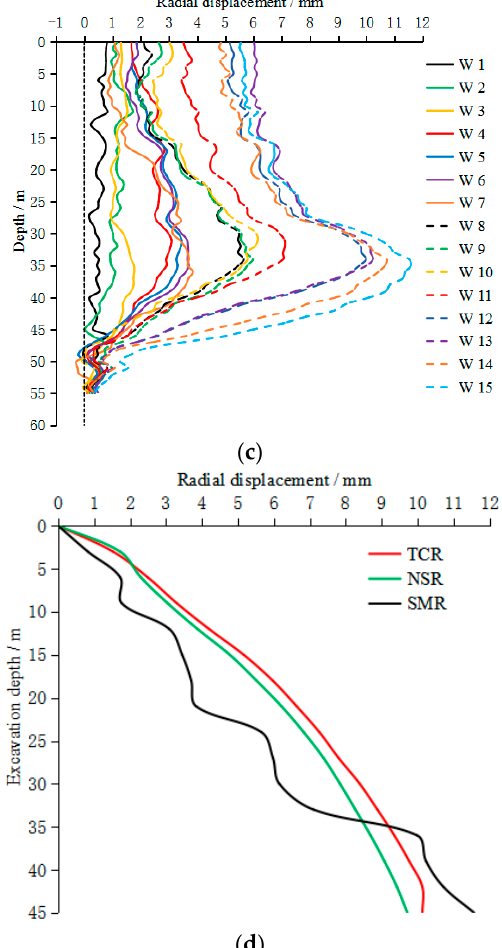
Figure 10. Radial displacement results of the circular diaphragm wall at Point A. ( a ) Variation of radial displacements obtained by CCSTCM with depth in different working conditions. ( b ) Variation of radial displacements obtained by FENSM with depth in different working conditions. ( c ) Variation of radial displacements obtained by site monitoring with depth in different working conditions. ( d ) Variation of maximum radial displacements with excavation depth.